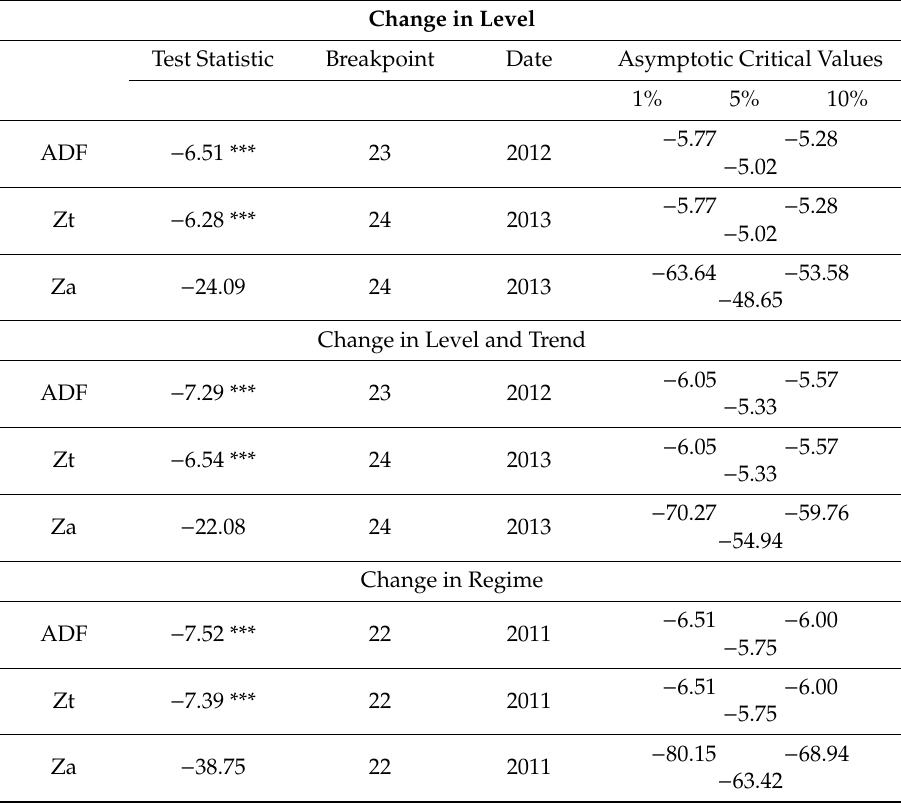
Table 6. Gregory–Hansen test for co-integration with regime shifts (CO 2 ).